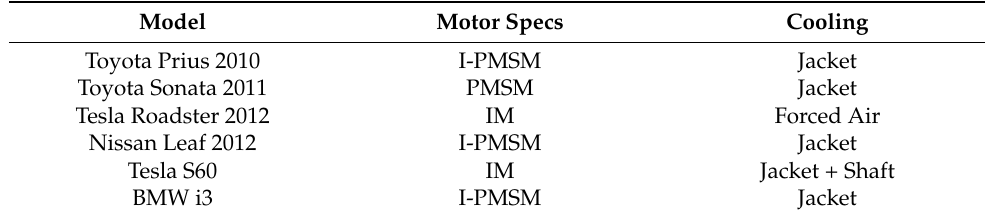
Table 5. Cooling methods employed by different manufacturers [84].